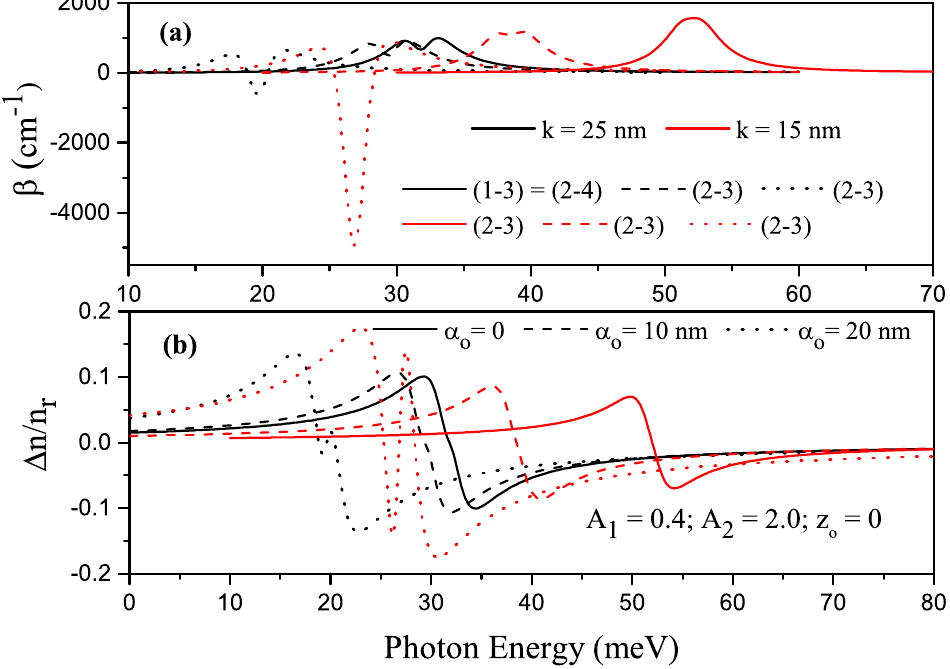
Figure 6. For the transitions between energy levels in parabolic–Gaussian symmetric DQW with parameters z o = 0, A 1 = 0.4 and A 2 = 2.0, ( a ) change in total absorption coefficients versus the photon energy; ( b ) variation in the total refractive index versus the photon energy, where black (red) curves are for k = 25nm ( k = 15nm ) and solid, dashed, and dotted curves are for α o = 0, α o = 10nm, and α o = 20nm,